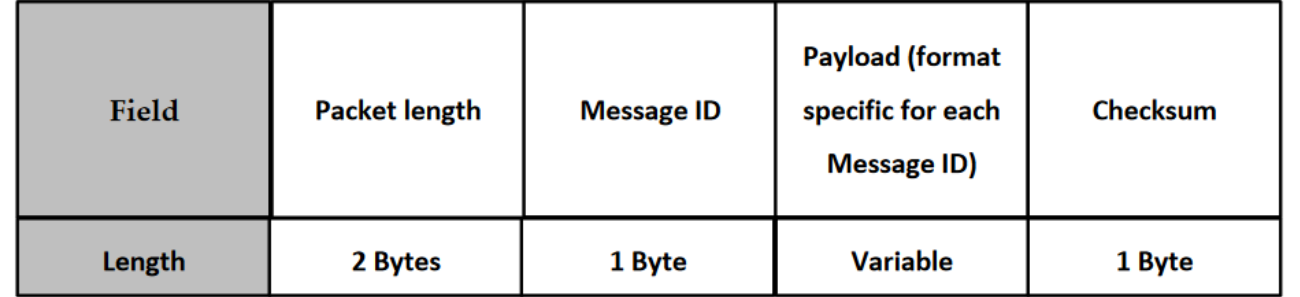
Figure 4. Generic packet format for EBI packets [35].